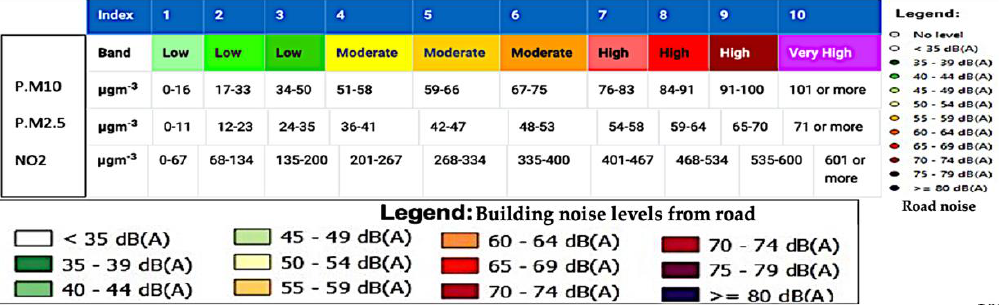
Figure 7. Joint annual average NO2 , PM 10 and PM 2.5 concentration(μg/m 3 ), and noise level (Lden) at five monitoring locations (23 November,2021): ( a ) Joint air- noise pollution (Lden)/(μg/m3) at GHS, GT and GK; ( b ) Joint air- noise pollution (Lden)/ (μg/m3) at EDB ; ( c ) Joint air-noise pollution (Lden)/ (μg/m3) at EDK.